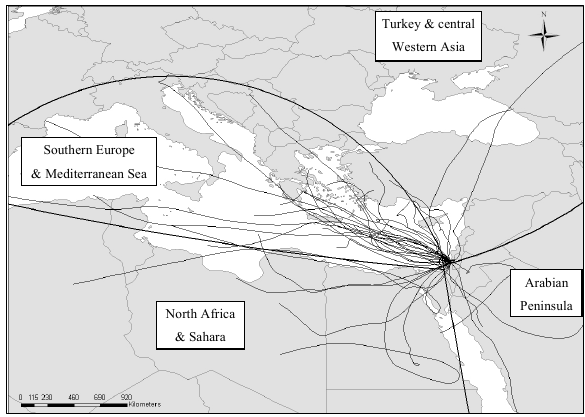
Fig. 7. Distribution of the trajectories according to air directions typical to Israel region. The trajectories are separated into 4 sectors (Dayan and Levi, 2005) that were categorized according to the main air directions common in the area. The major sources are: south- ern Europe & Mediterranean Sea, Turkey & central western Asia, Arabian Peninsula and North Africa &